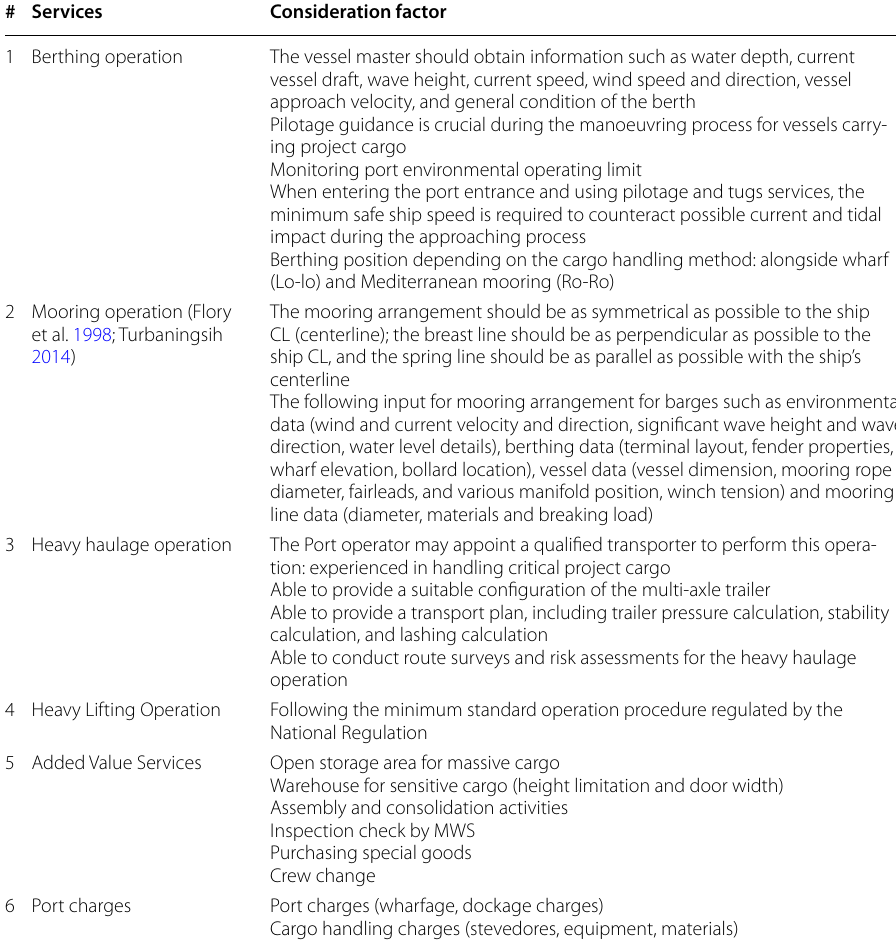
Table 5 Planning project cargo operation